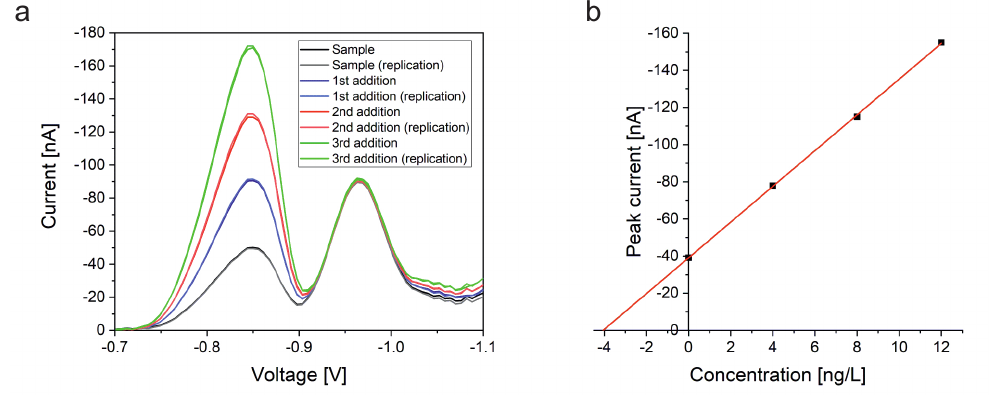
Figure 10. ( a ) Recorded voltammograms of fuel cell product water collected during the continous high load cycle and the corresponding results of the standard addition calibration as measured by HMDE. ( b ) Resulting calibration curve with linear regression (red line) after background